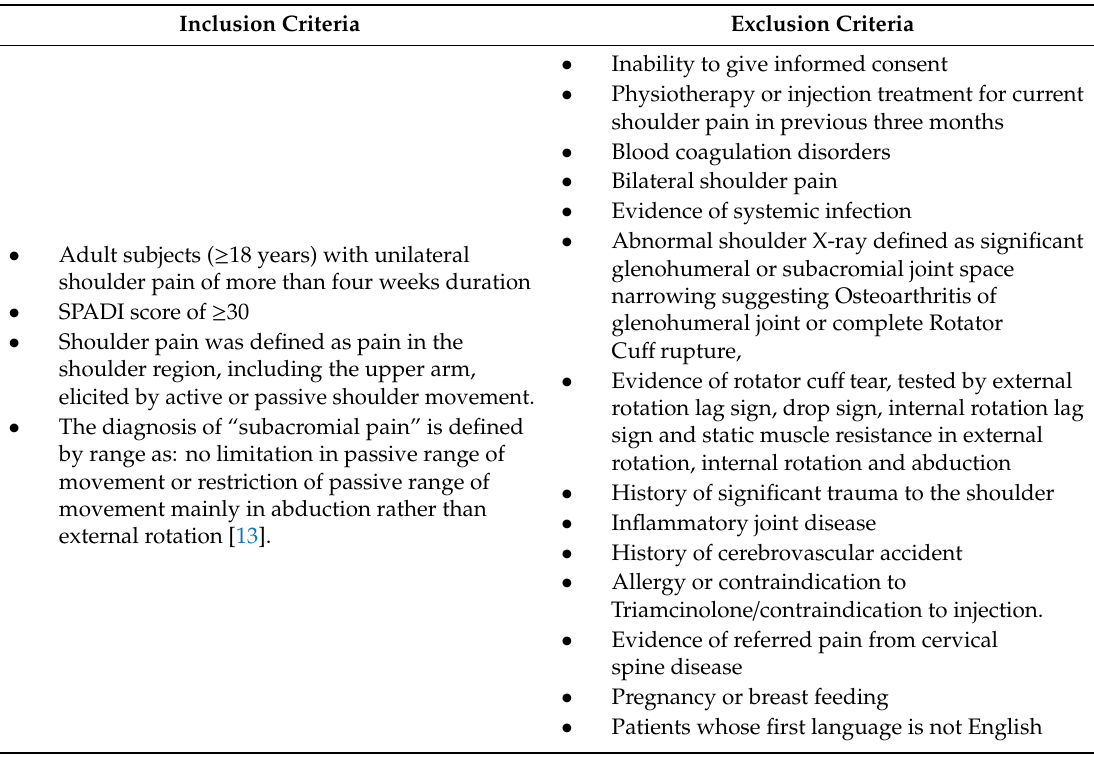
Table 1. Inclusion and exclusion